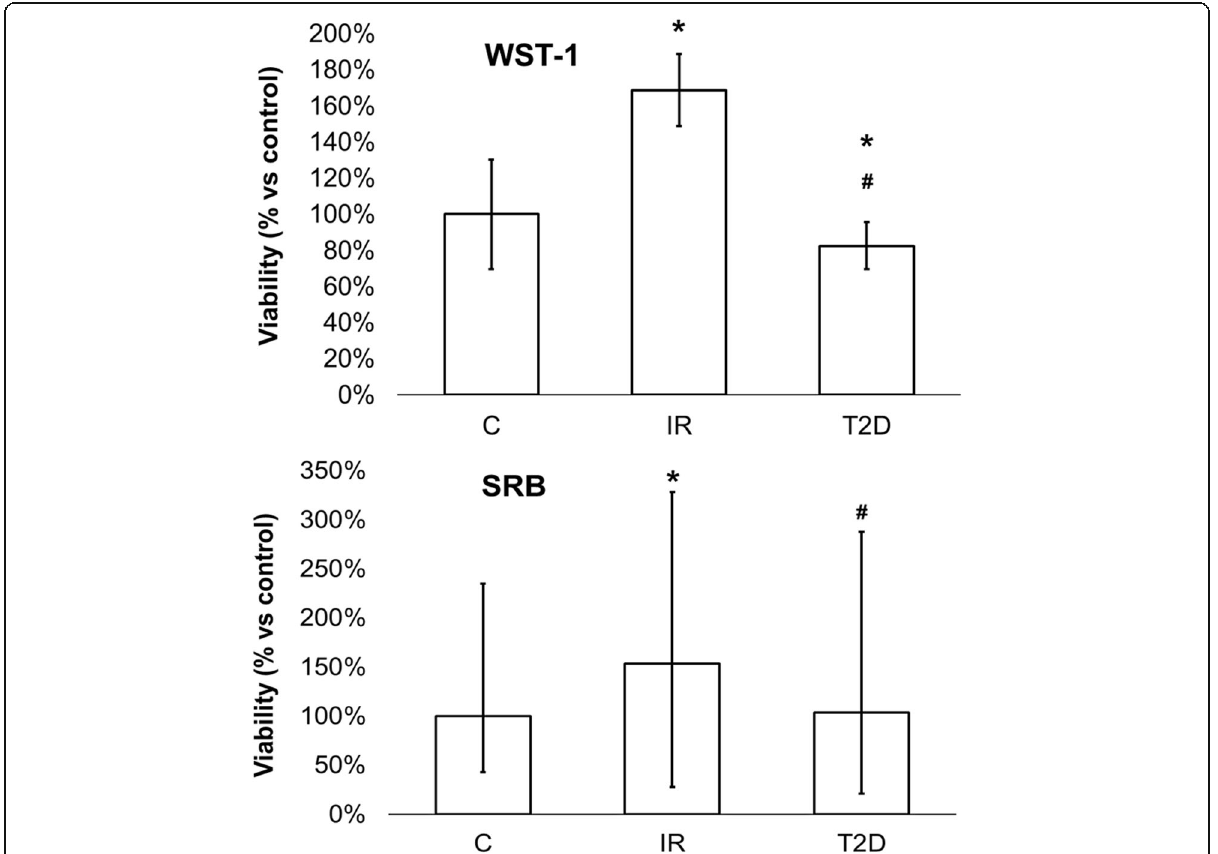
Fig. 1 Cells viability based on the measurement of mitochondrial oxidative (WST-1 assay) in cells and total protein content (SRB assay) from patients with insulin-resistance (IR), type 2 diabetes (T2D) compared to control cells (C) from healthy people. The bars represent the means ± standard deviation (SD), ANOVA with the Tukey post hoc test (WST-1 assay) and the (Me) with the 25 th and 75 th quartiles and the minimum and maximum; the Kruskal Wallis test with post hoc (SRB assay), * p <0.05 vs. C, # p <0.05 vs. IR